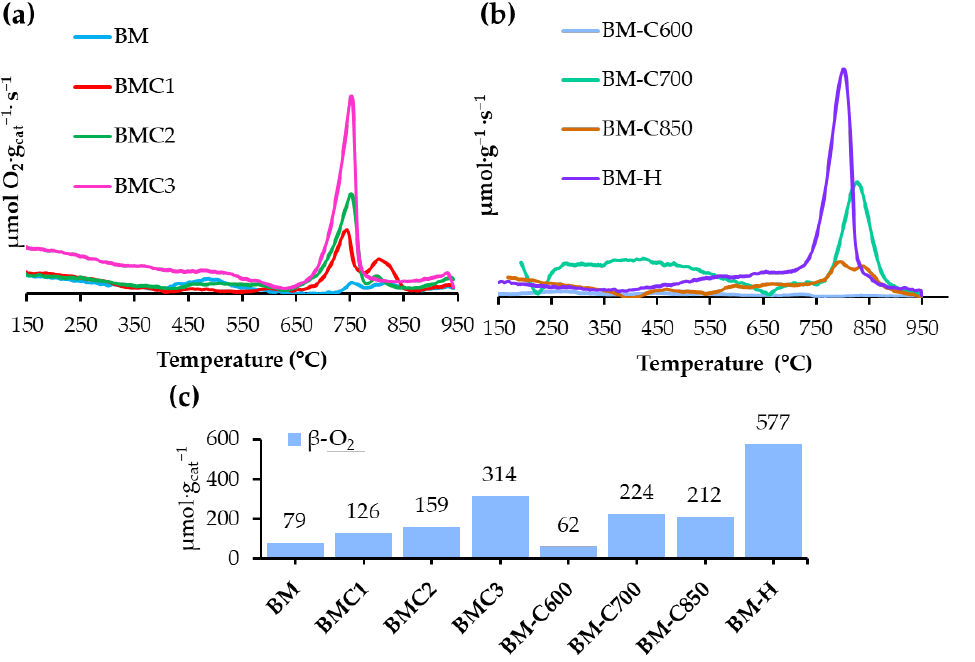
Figure 5. O 2 -TPD profiles for ( a ) BaMn 1 − x Cu x O 3 catalysts serie, ( b ) BaMnO 3 catalysts serie and ( c ) amount of β -O 2 emitted during O 2 -TPD experiments.